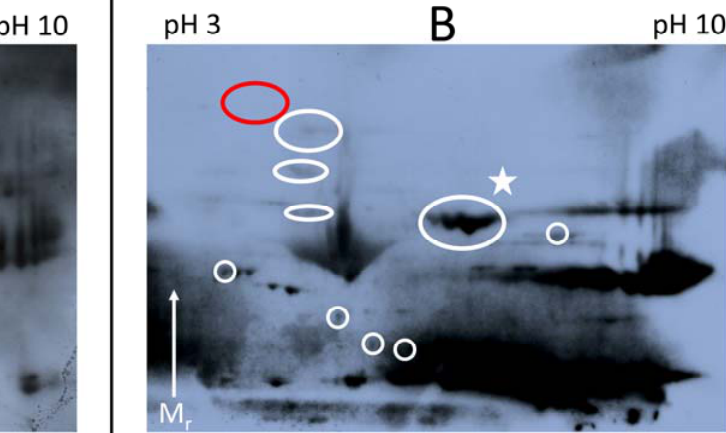
Figure 2. ( A and B ): 2D Western blot (225 µg protein load, P517 ascites, IPG